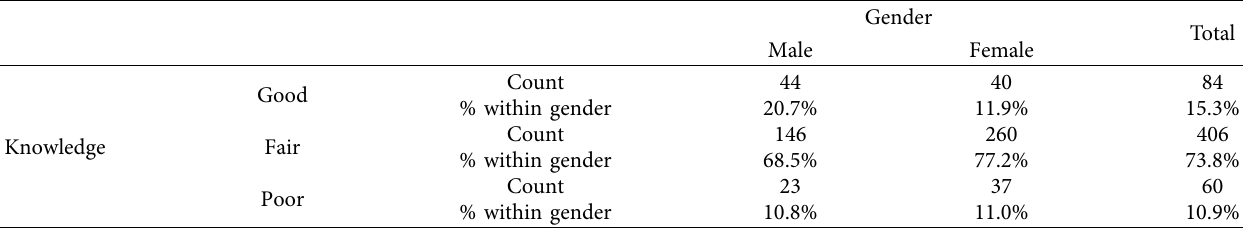
Table 4: Distribution of school teachers based on knowledge and gender.